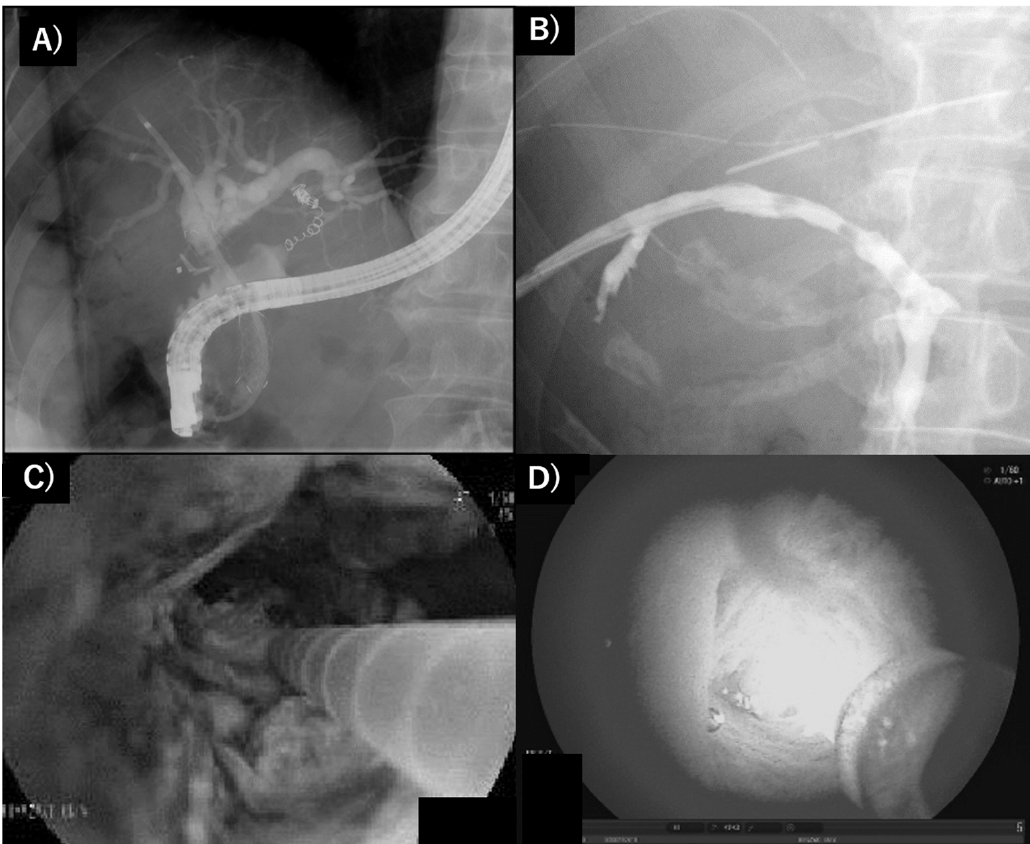
Figure 1. Endoscopic approaches for laser irradiation for PDT. ( A ) The transhepatic biliary drainage route; ( B ) intraductal placement image of laser fiber adjacent to tumor; ( C ) laser irradiation using laser fiber generated by the eximer dye laser or semi-conductor apparatus via endoscopy; ( D ) Cholangioscopic findings of laser irradiation at the biliary stricture due to invading cholangiocarcinoma.